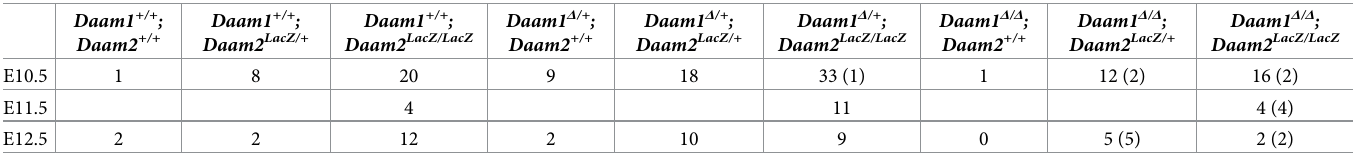
E10.5 and E12.5 embryos were obtained from inter se crosses of Daam1 Δ /+ , Daam2 LacZ/+ or Daam1 Δ /+ , Daam2 LacZ/LacZ mice. E11.5 embryos were obtained from inter se crosses of Daam1 Δ /+ , Daam2 LacZ/LacZ mice. Numbers of dead embryos are indicated in